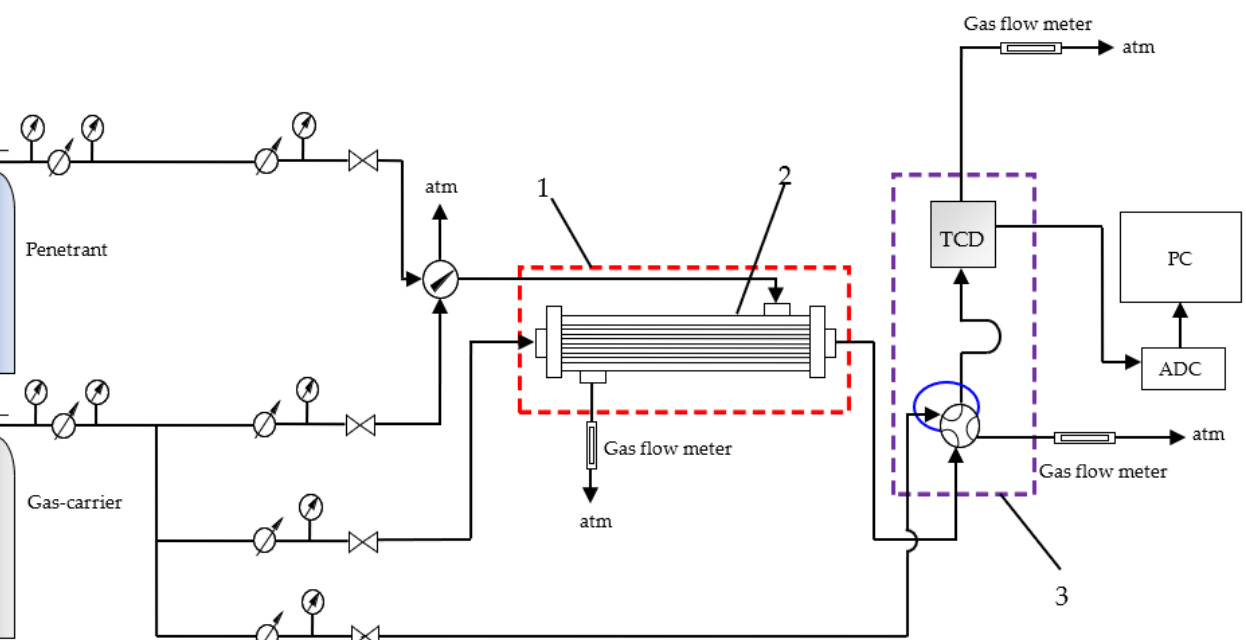
Figure 6. Scheme of the experimental setup for determining gas transport parameters: (1) thermocryostat (Huber CC 410), (2) HF membrane cell, (3) gas chromatograph (Crystal 2000m).